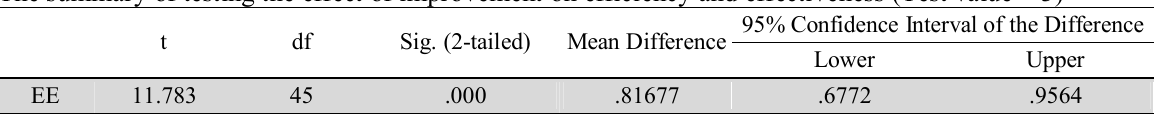
The summary of testing the effect of improvement on efficiency and effectiveness (Test value = 3)